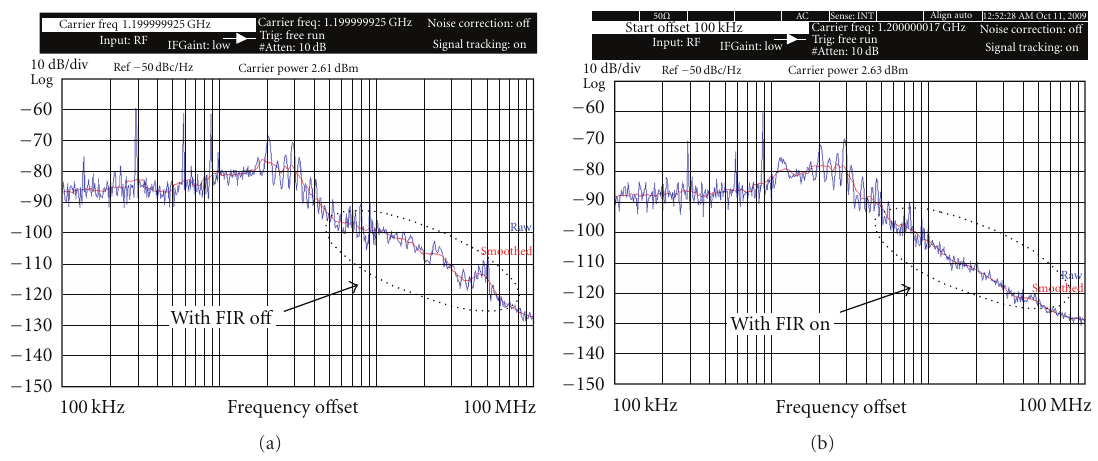
Figure 13: Measured output spectra: (a) with FIR disabled and (b) with FIR enabled.